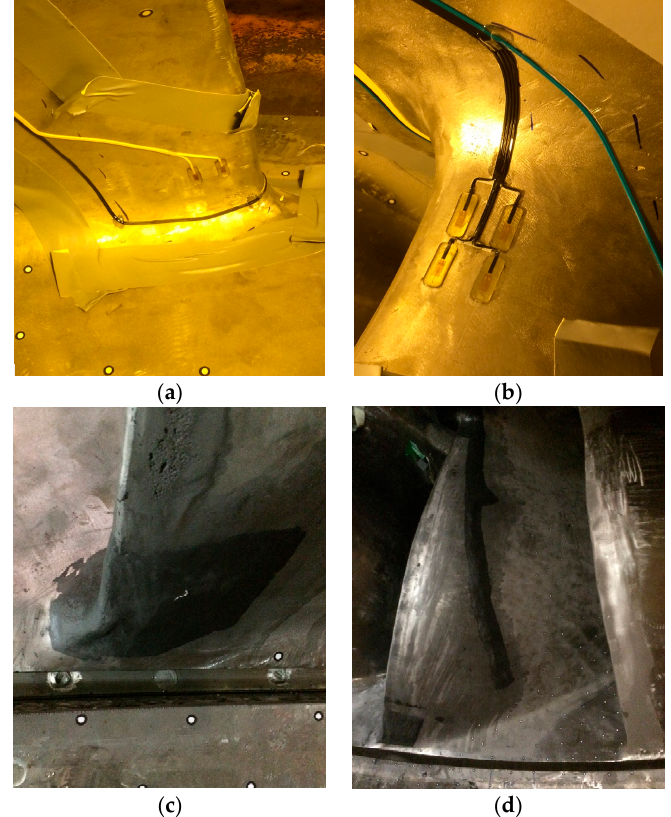
Figure 2. Detail of the strain gauges installed in the runner. ( a ) Strain gauges in the pressure side and band side; ( b ) strain gauges in the suction side and crown side; ( c , d ) detail of the epoxy resin covering the strain gauges.